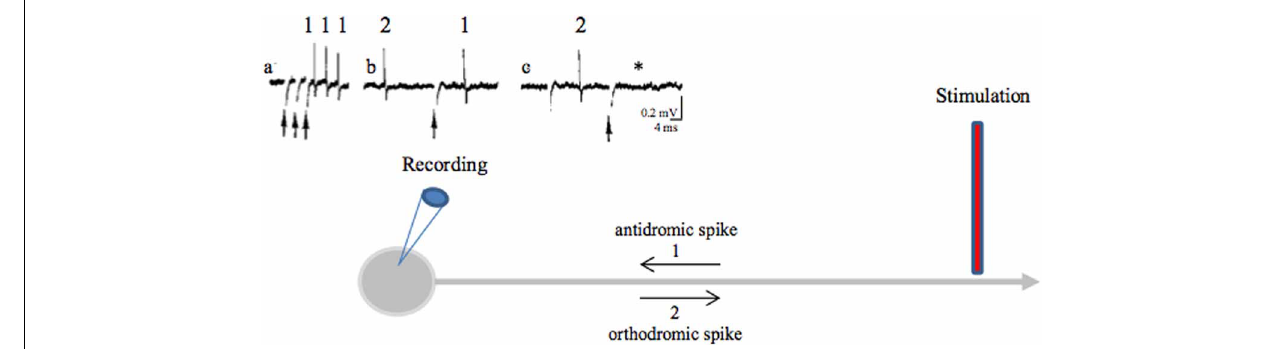
FIGURE 3 | Antidromic spikes. The antidromic propagation of a spike refers to its conduction in a direction opposite from the normal (orthodromic) direction (away from axon terminals to soma instead of propagating from the initial segment of the axon, close to the soma, toward axon terminals). To evoke antidromic spikes, axons are directly stimulated with a suprathreshold stimulus. Evoked spikes propagate in both directions (orthodromic and antidromic). This shows that axons do not have a preferential direction of conduction: the direction of propagation is given by the synapses, which are unidirectional [from the axon terminal (presynaptic element) to the postsynaptic element]. Antidromic activation is often used in a laboratory setting to confirm that a recorded neuron projects to the structure of interest. During HF DBS, antidromic spikes are evoked because an extracellular stimulation preferentially activates axons (axon terminals, passing axons). Criteria for identification of an antidromic spike are: (i) Stability of latency (because there are no synapses between